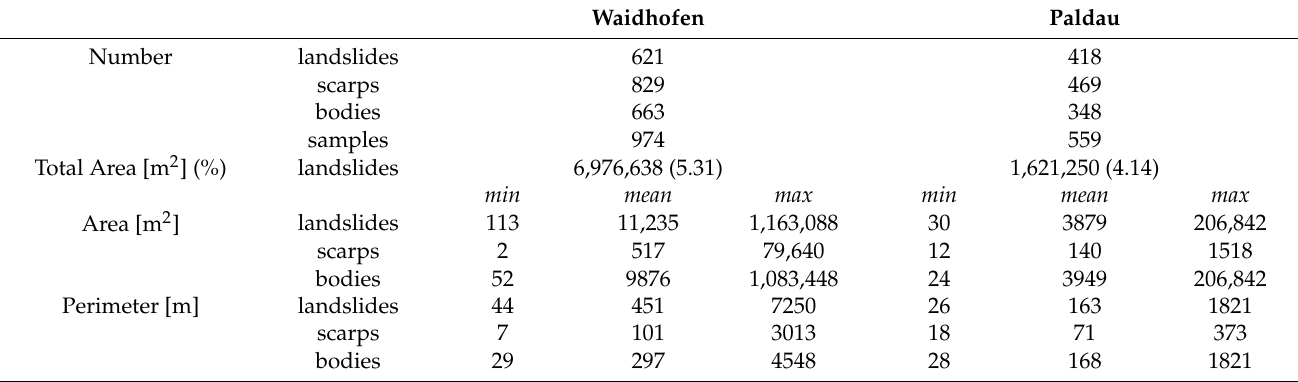
Table A3. Summary of the landslide inventory